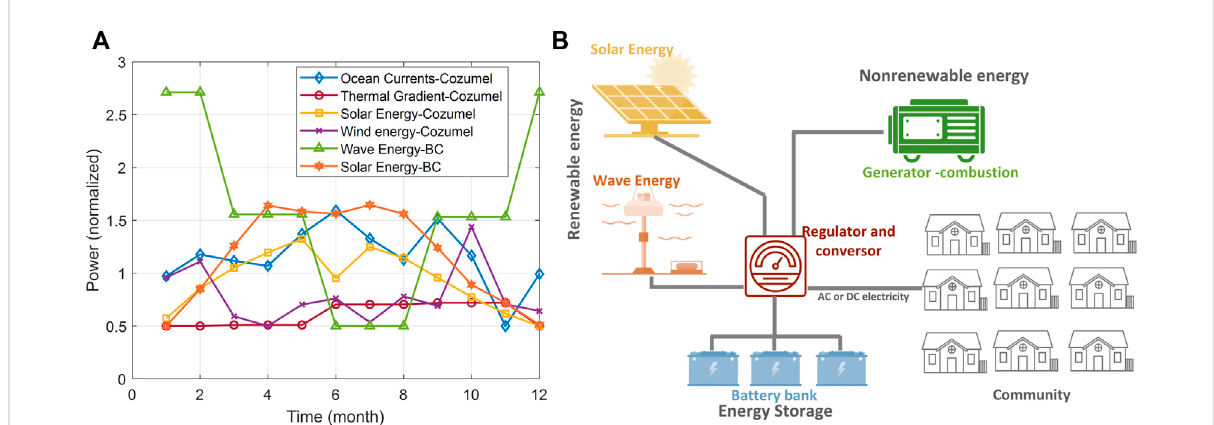
FIGURE 1 (A) Mean monthly variability for different MREs in Cozumel and Baja California. Data taken from CEMIE-Oceano research (Garduño-Ruiz et al., 2021; Gorr-Pozzi et al., 2021; Olmedo-González et al., 2021; Tobal-Cupul et al., 2022). Note: The power units are “ normalized ” because the graph only represents the power variation considering a minimum power generation of 0.5 units. (B) An off-grid, hybrid energy system for isolated